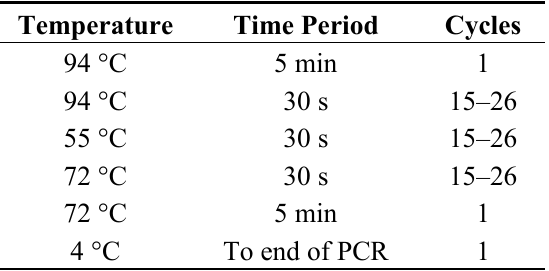
Table 3. PCR phase conditions applied in metagenomics analysis of the samples collected from the